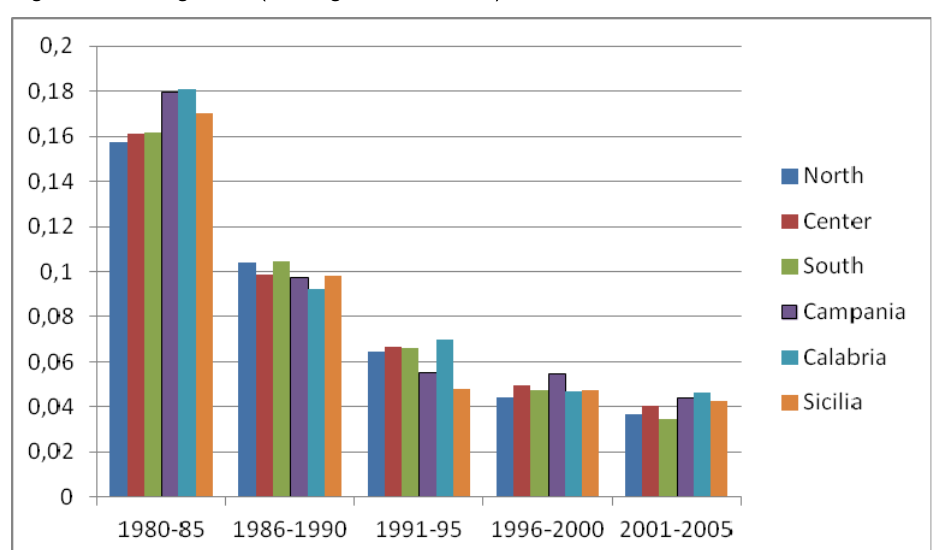
Figure 2. GDP growth (average annual data)